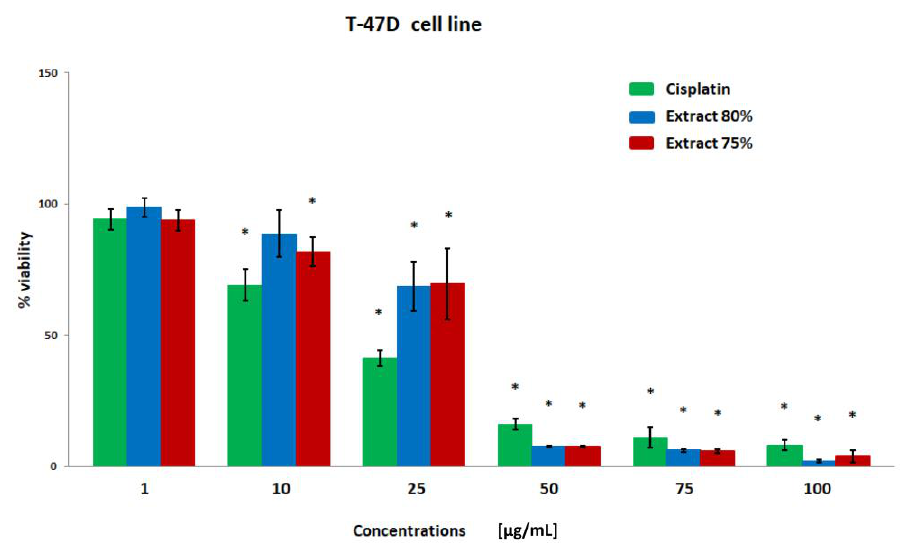
Figure 4. The viability of the T-47D cell line (%) after 24 h incubation with various concentrations of cisplatin, extract 80%, and extract 75% measured with MTT test. Significant values (*) compared with Cisplatin with p < 0.05 (one-way ANOVA with Tukey’s post hoc test). The identified compounds in the propolis extract produced by Decont belong to var- ious classes in terms of properties against human cell receptors [36]. The selected com- pounds identified in the extract that show biological activity towards estrogen receptors are presented in Table 1. Table 1. Selected compounds identified in the low-temperature propolis extract that show biological activity towards estrogen receptors.